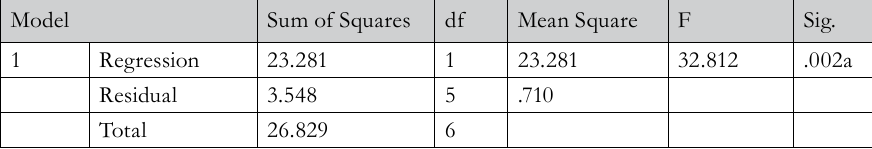
Tab. 13 – ANOVA b – Hungary. Source: own